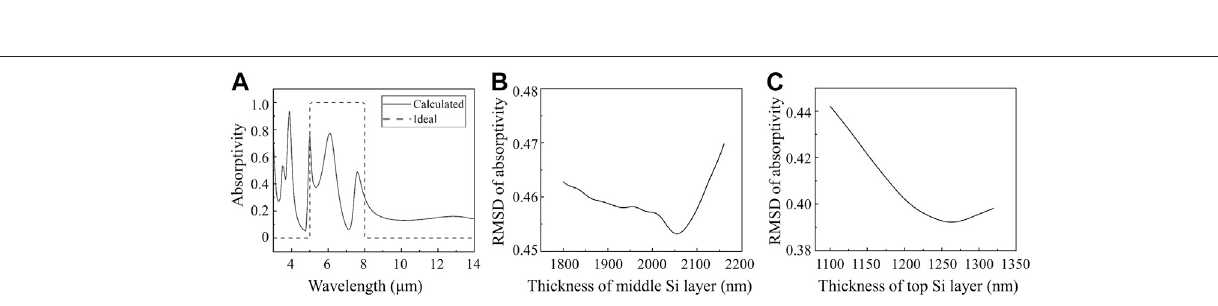
Frontiers in Physics |